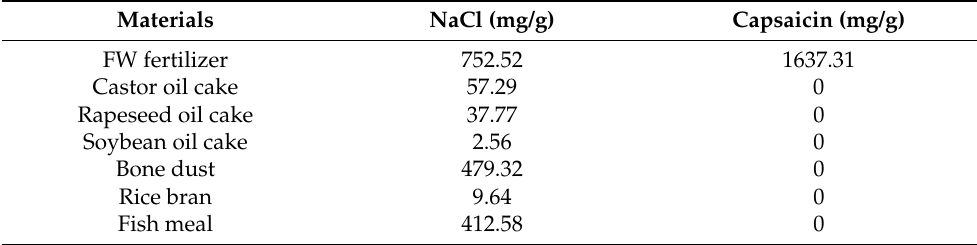
Table 1. NaCl concentrations of major materials used for organic fertilizer in